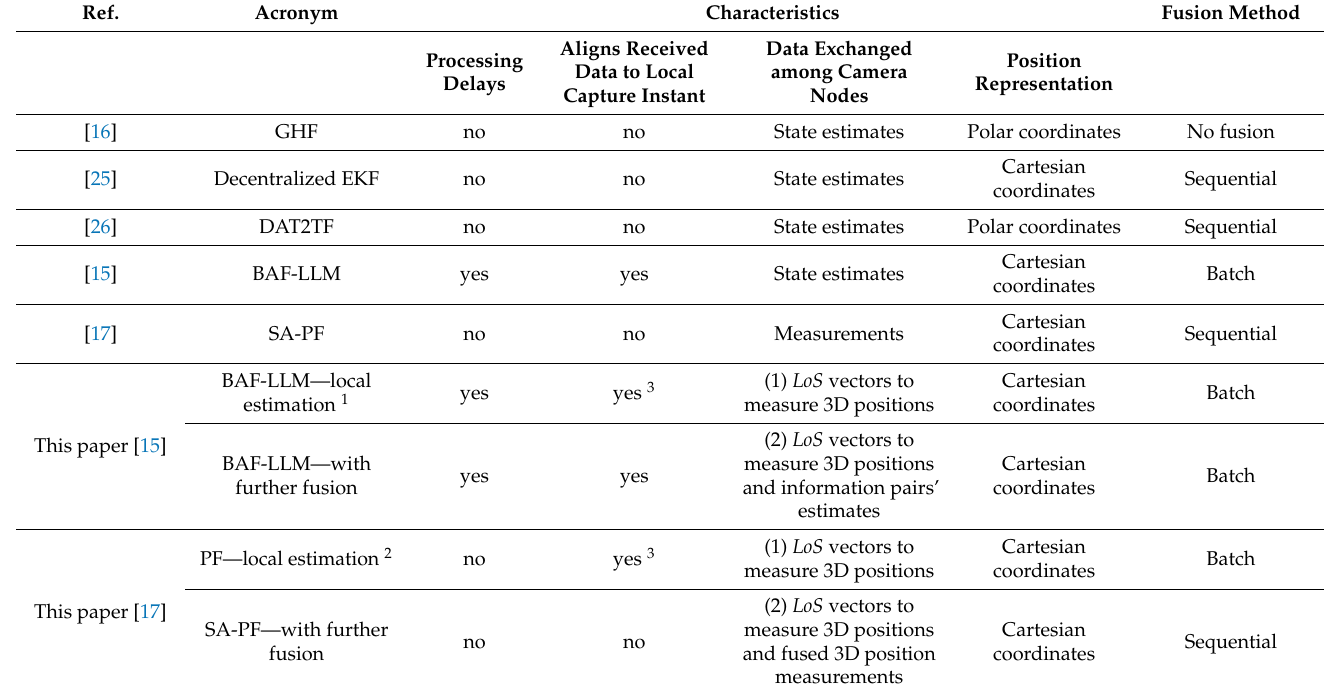
Table 1. Analytical